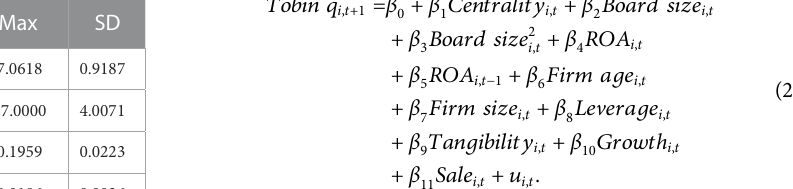
TABLE 4 Descriptive statistics. This table reports the minimum, mean, median, and maximum values of each variable used in our model. It also shows the respective standard deviations. Detailed variable descriptions are given in Section 3.1. All variables are winsorized at the 1st and 99th percentile levels.